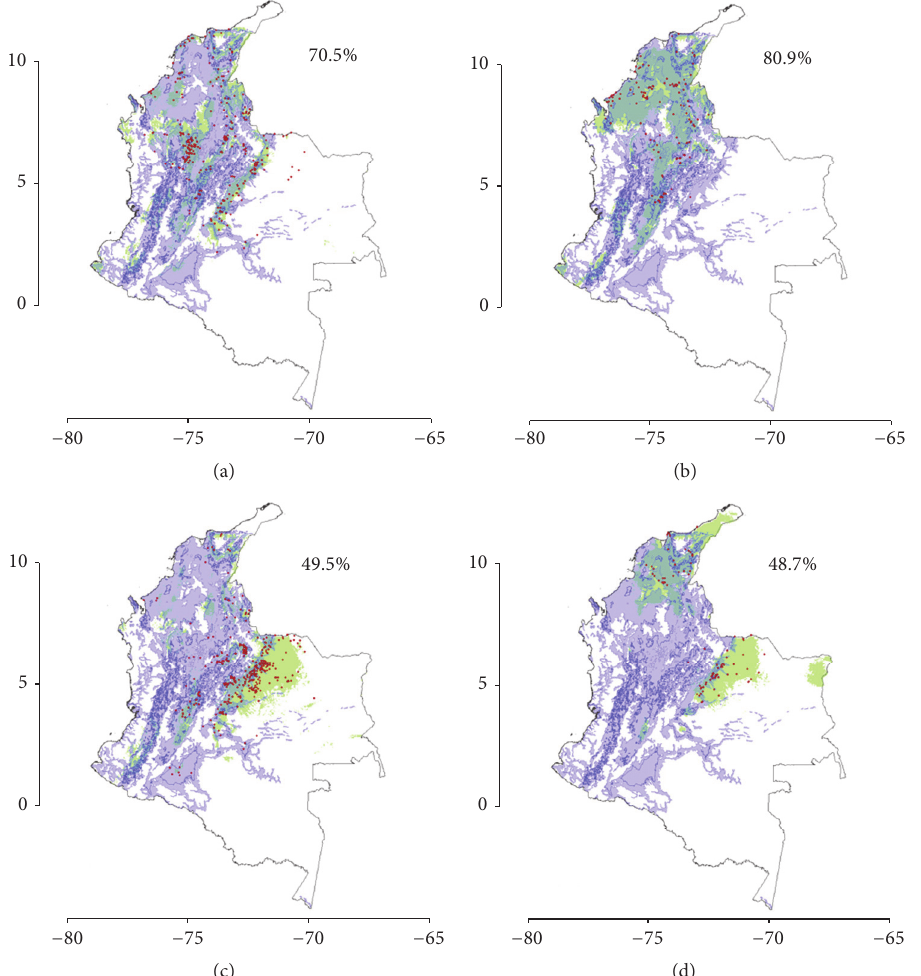
Figure 4: Proportion of species found in transformed ecosystems versus natural ecosystems for the predicted distribution of the Triatominae species. (a) Panstrongylus geniculatus ; (b) Rhodnius pallescens ; (c) Rhodnius prolixus ; (d) Triatoma maculata . Green areas show the potential distribution of each of the species, red points are the occurrence data for each species, and blue areas indicate the transformed ecosystem according to the classification of Etter’s (1998) ecosystem map. The percentage species distributed in transformed ecosystems is shown in the top right hand corner of each